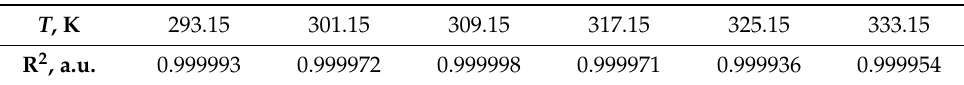
Table 1. R 2 values for the approximation of polynomial permittivity for different measurement temperatures.